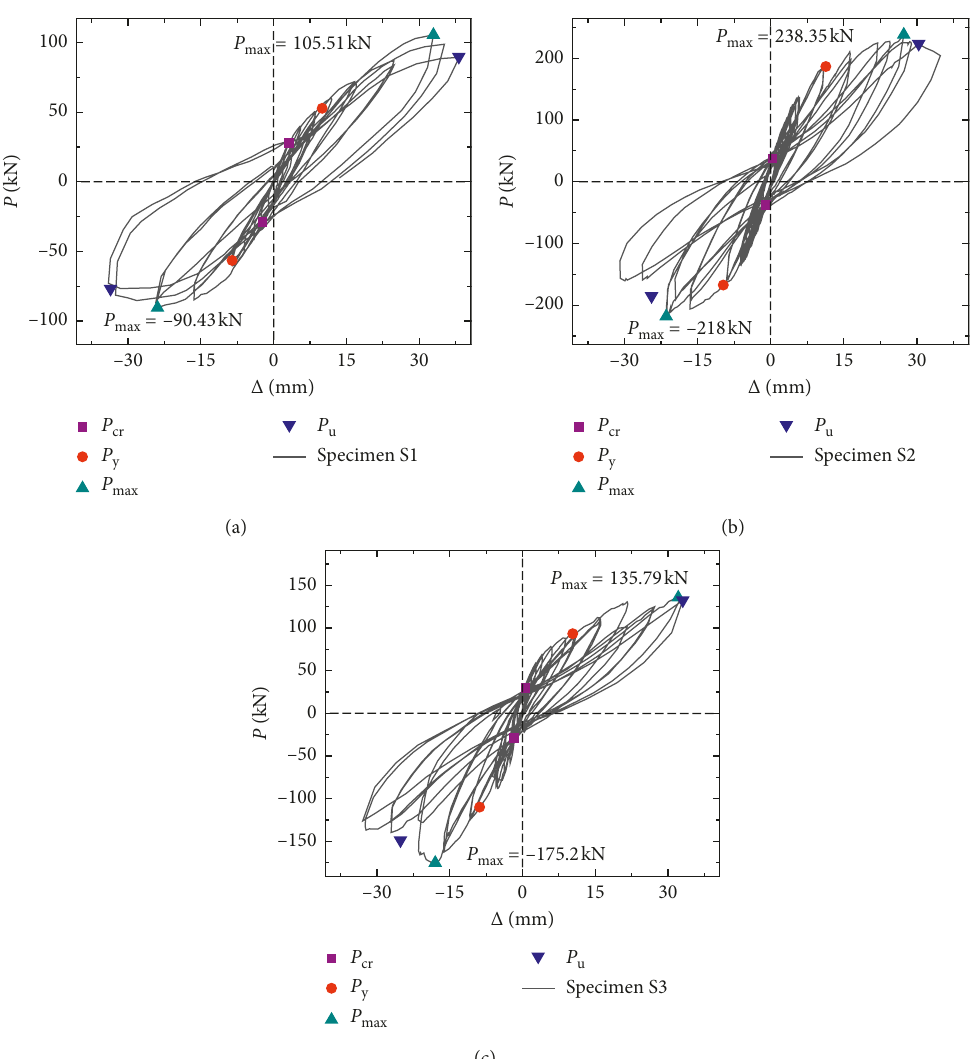
Figure 6: P- hysteretic curves. (a) Specimen S1. (b) Specimen S2. (c) Specimen Δ